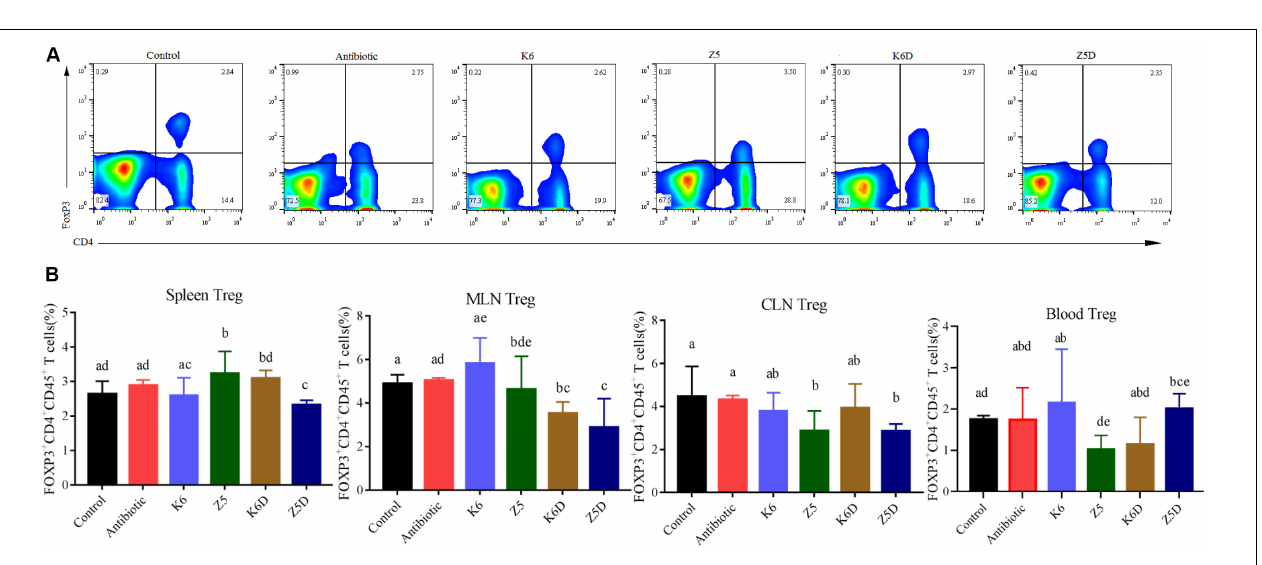
FIGURE 6 | Treg inhibition and its role in DSS-induced colitis in mice. (A,B) Flow plots and quantification of Tregs in the spleen and in the spleens, MLNs, CLNs, and blood in each group. Different letters indicate significant differences ( P < 0.05, one-way ANOVA) between different groups (mean ± SD, n = 3–7 mice per